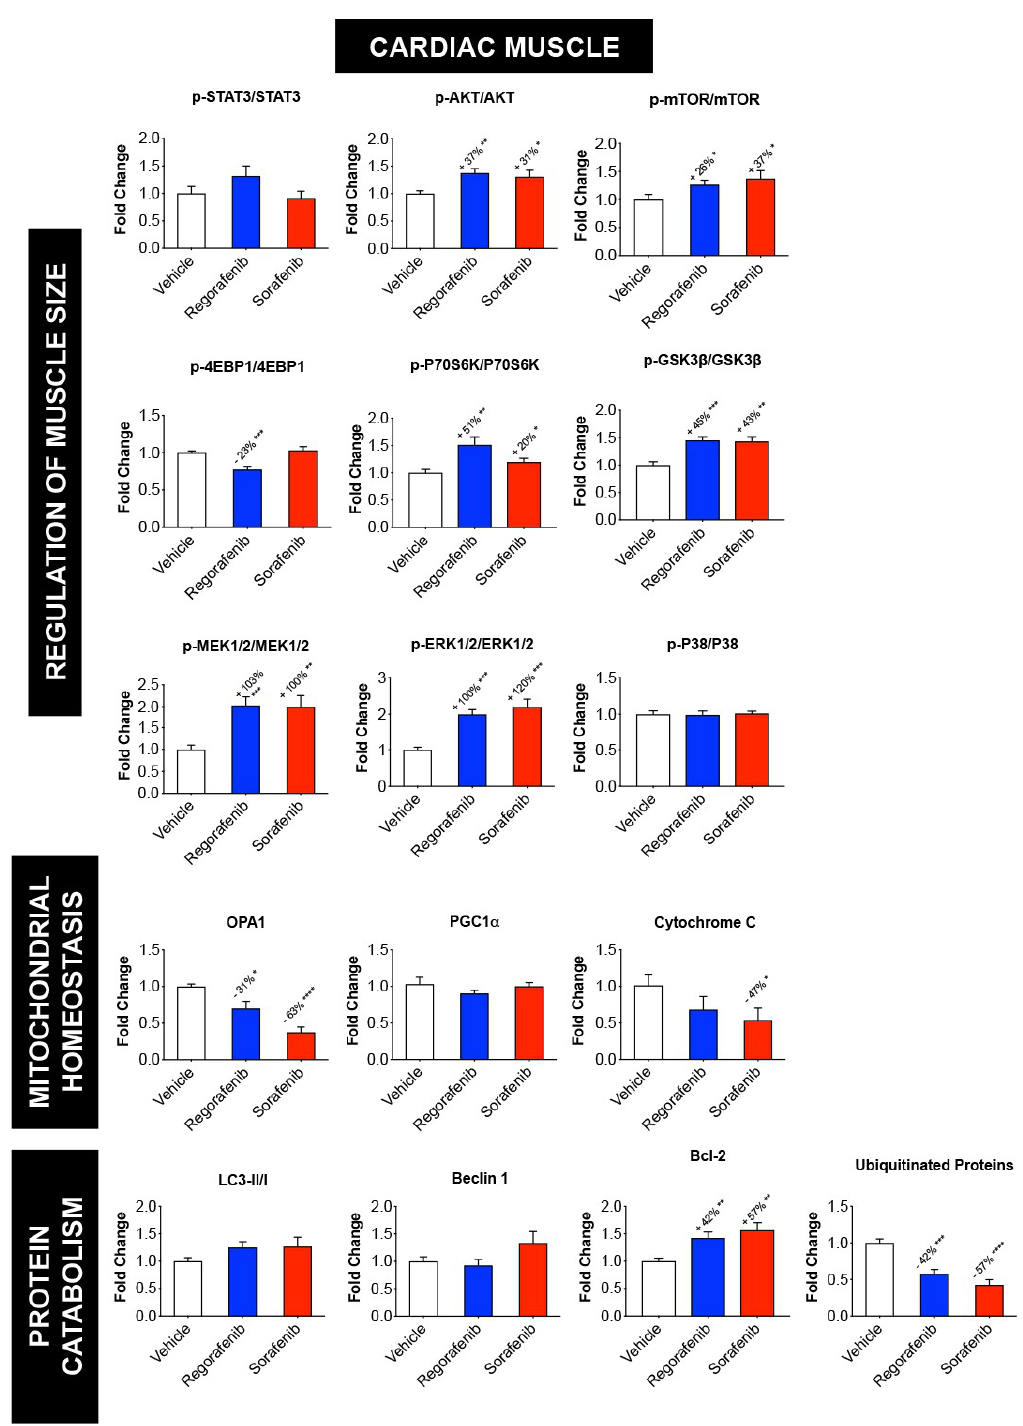
Figure 6. Regorafenib and sorafenib alter cachexia-associated pathways in cardiac muscle. Representative western blotting and quantification (expressed as fold change vs. Vehicle) of proteins involved in the regulation of muscle size (STAT3, AKT, mTOR, 4EBP1, P70S6K, GSK3β, P38, MEK1/2, ERK1/2) (Top), proteins involved in mitochondrial homeostasis (OPA1, PGC1α, Cytochrome C) (Middle), and markers of protein catabolism, (LC3, Beclin 1, Bcl-2 and total ubiquitinated proteins) (Bottom) in whole cardiac muscle protein extracts from mice treated with 30 mg/kg/day regorafenib (blue; n = 8), 60 mg/kg/day sorafenib (red; n = 8), or vehicle (white; n = 8) over the course of 6 weeks. Levels of phosphorylated proteins were normalized to their respective total protein. Tubulin served as the loading control. Data presented as mean ± SEM. Significance of the difference: * p < 0.05, ** p < 0.01, *** p < 0.001, **** p < 0.0001 vs. Vehicle.